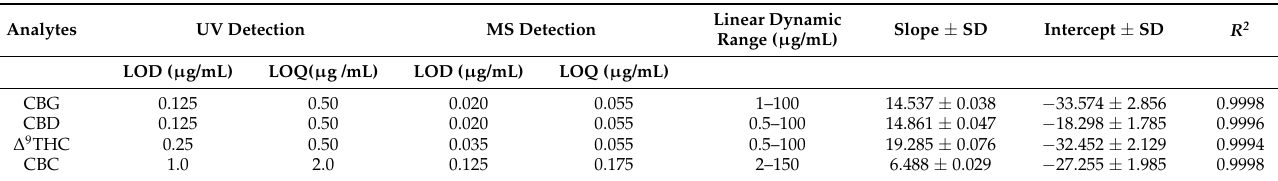
Table 2. Sensitivity and calibration data of the nano-LC-UV